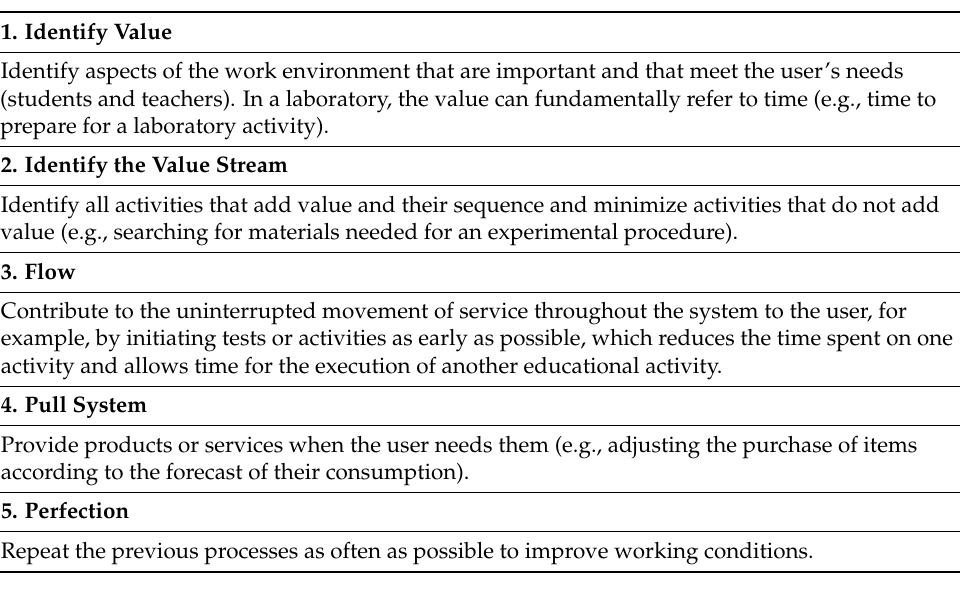
Table 1. Lean principles in a laboratory context of teaching and